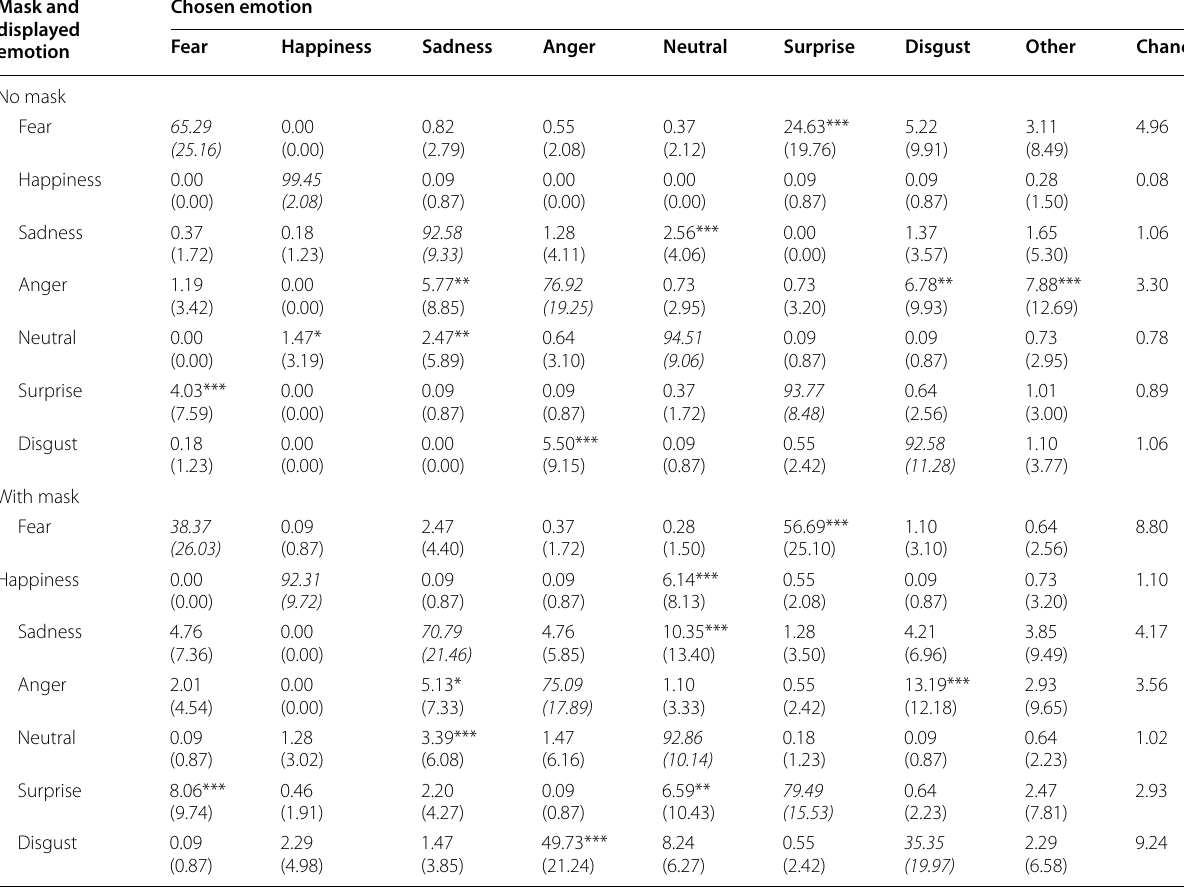
the hits. Percentages are rounded to two digits and may not add up to exactly